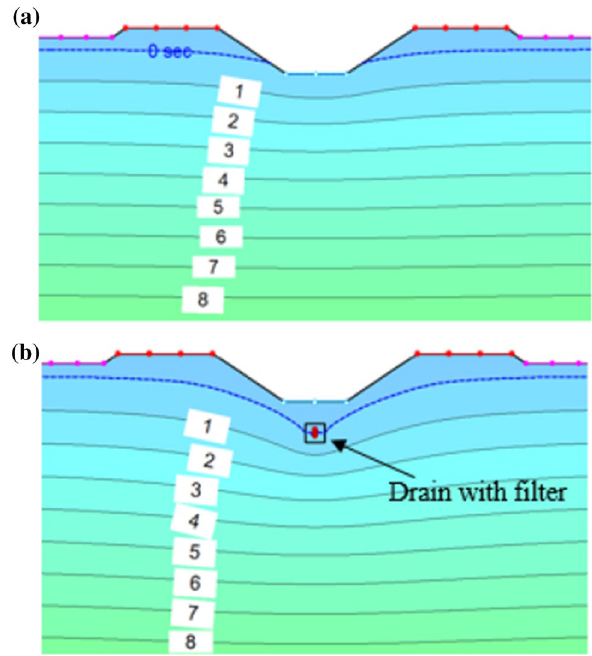
Fig. 15 Pressure contours a without drain pipes, H = 20.8 m, b with a drain and filter, t = 0.25 m, D = 0.2 m, Y = 19 m, H = 20.8